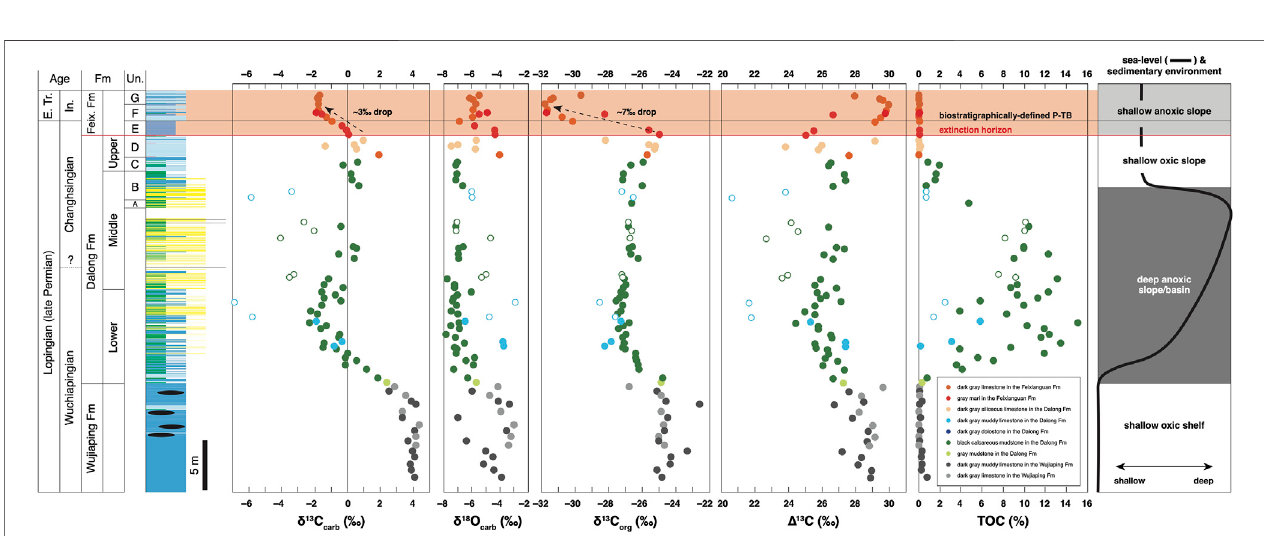
FIGURE 4 | Chemostratigraphy of the analyzed P-TB interval at Chaotian. The δ 13 C org values and TOC contents were previously reported in Saitoh et al. (2014a). Open symbols represent samples with anomalously low δ 13 C carb values in the Dalong Formation.